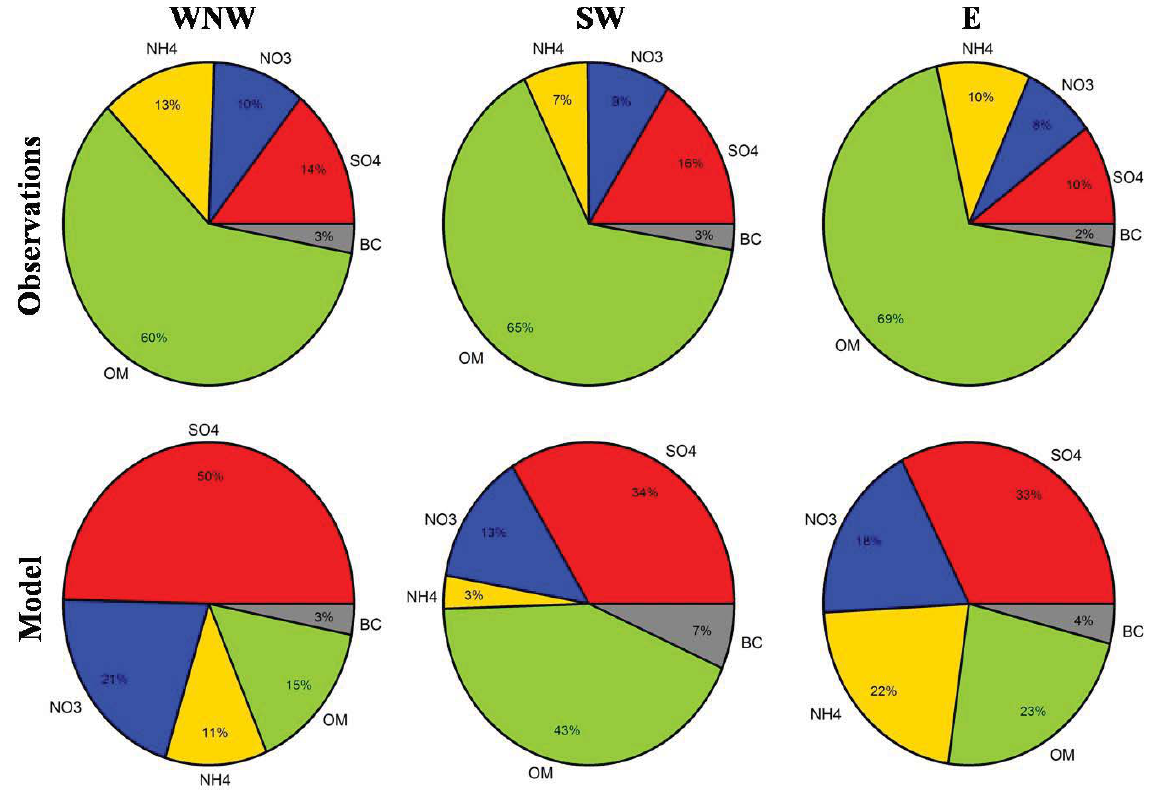
Fig. 5. These diagrams show how the inorganic and organic compounds measured with the AMS and simulated in the model are petitioned with respect to the origin of the air masses.